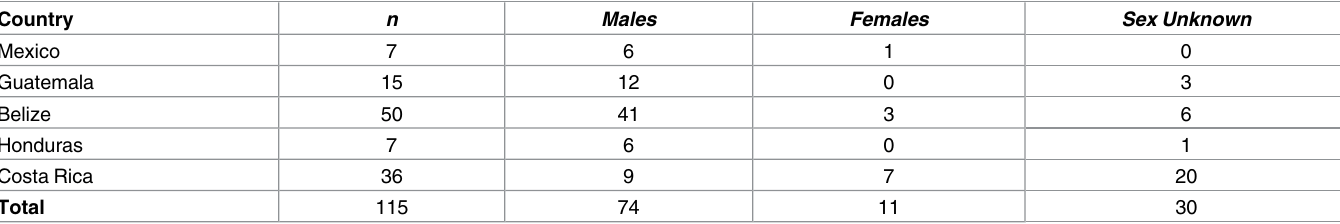
Table 1. DNA sample summary. Number of individualjaguars( n ) and number of males and females detected across five Mesoamerican countries (Belize, Costa Rica, Guatemala, Honduras,Mexico). Country n Males Mexico Belize